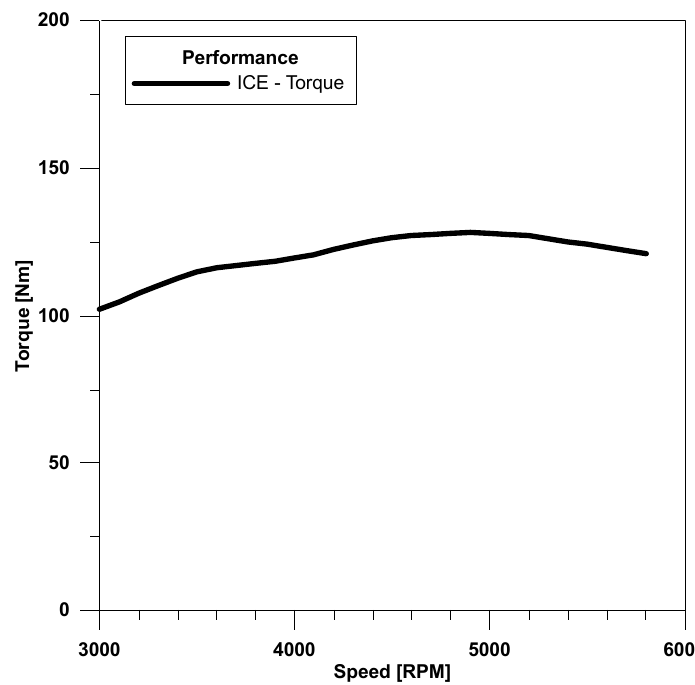
Figure 4. ICE maximum torque manufacturer’s curve.